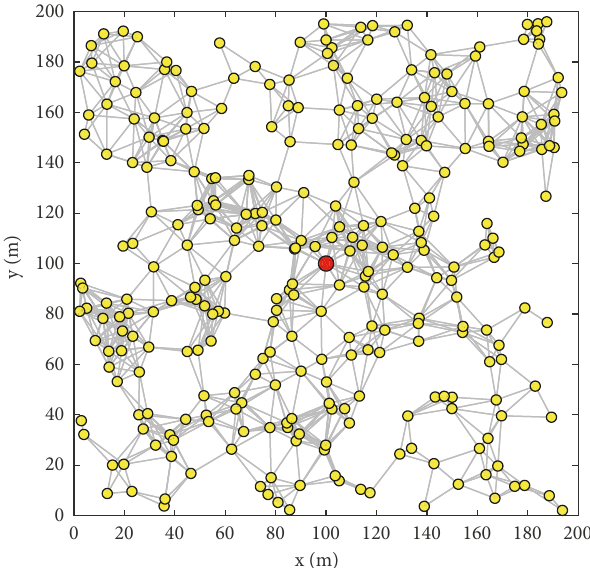
Figure4: Networktopology(300sensornodesaredeployed andthe sink node is marked in